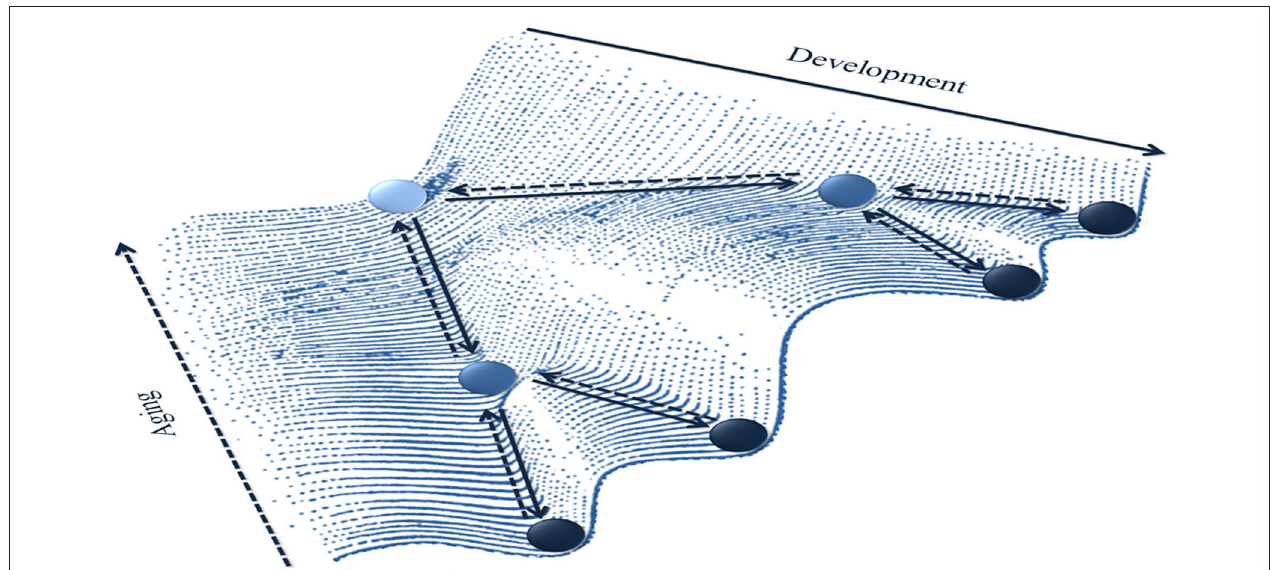
which a rolling ball can be trapped) increases through a differentiation process (filled lines arrows). Conversely, during aging (dashed lines arrows), the landscape goes through a dedifferentiation process leading to the disappearance or merging of some